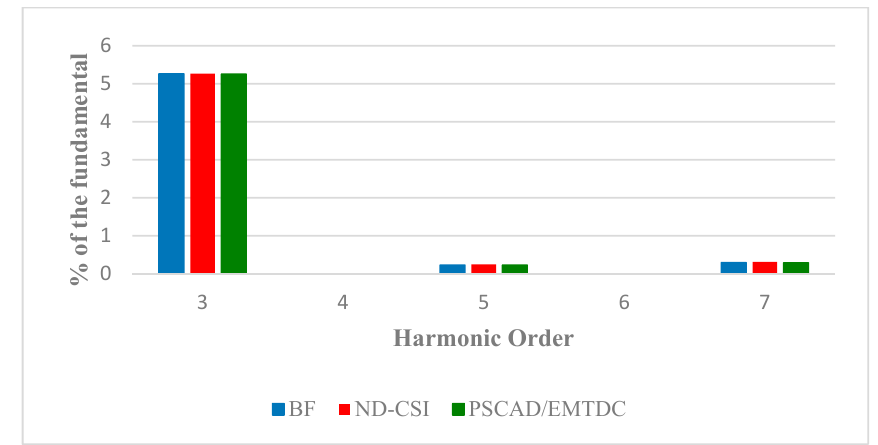
Figure 11. Harmonic content of current at PCC.